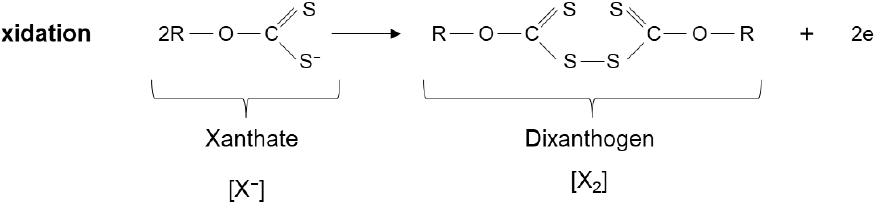
Figure 11. Formation of dixanthogen.